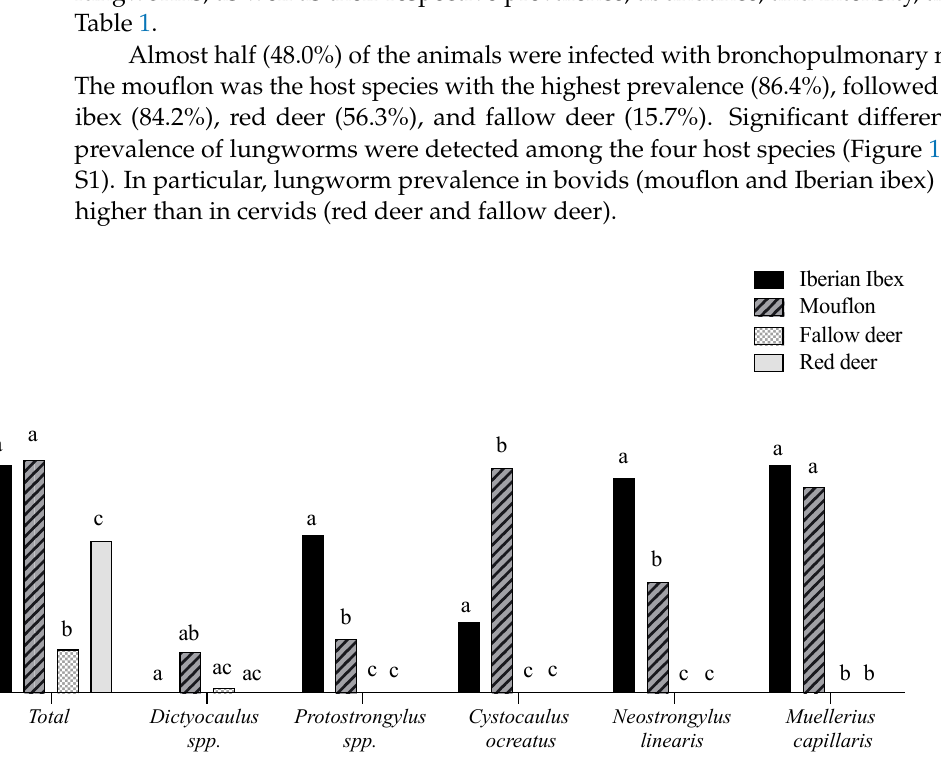
Figure 1. Total prevalence of bronchopulmonary nematodes and prevalence of the five commonly found genera and lungworm species. Different letters indicate significant differences between groups ( p < 0.05). Table 1. List of nematode species and their prevalence, abundance and intensity. P: Prevalence (%); A: Mean abundance (larvae per lung gram); I.R.: Intensity Range (minimum and maximum larvae per lung gram values). Minus values (--) represent parasites not analyzed in the host species.